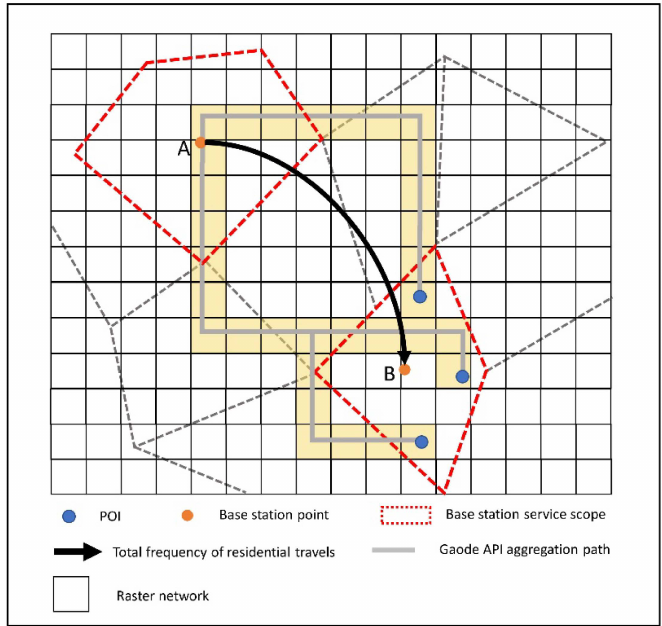
Figure 2. Path inference